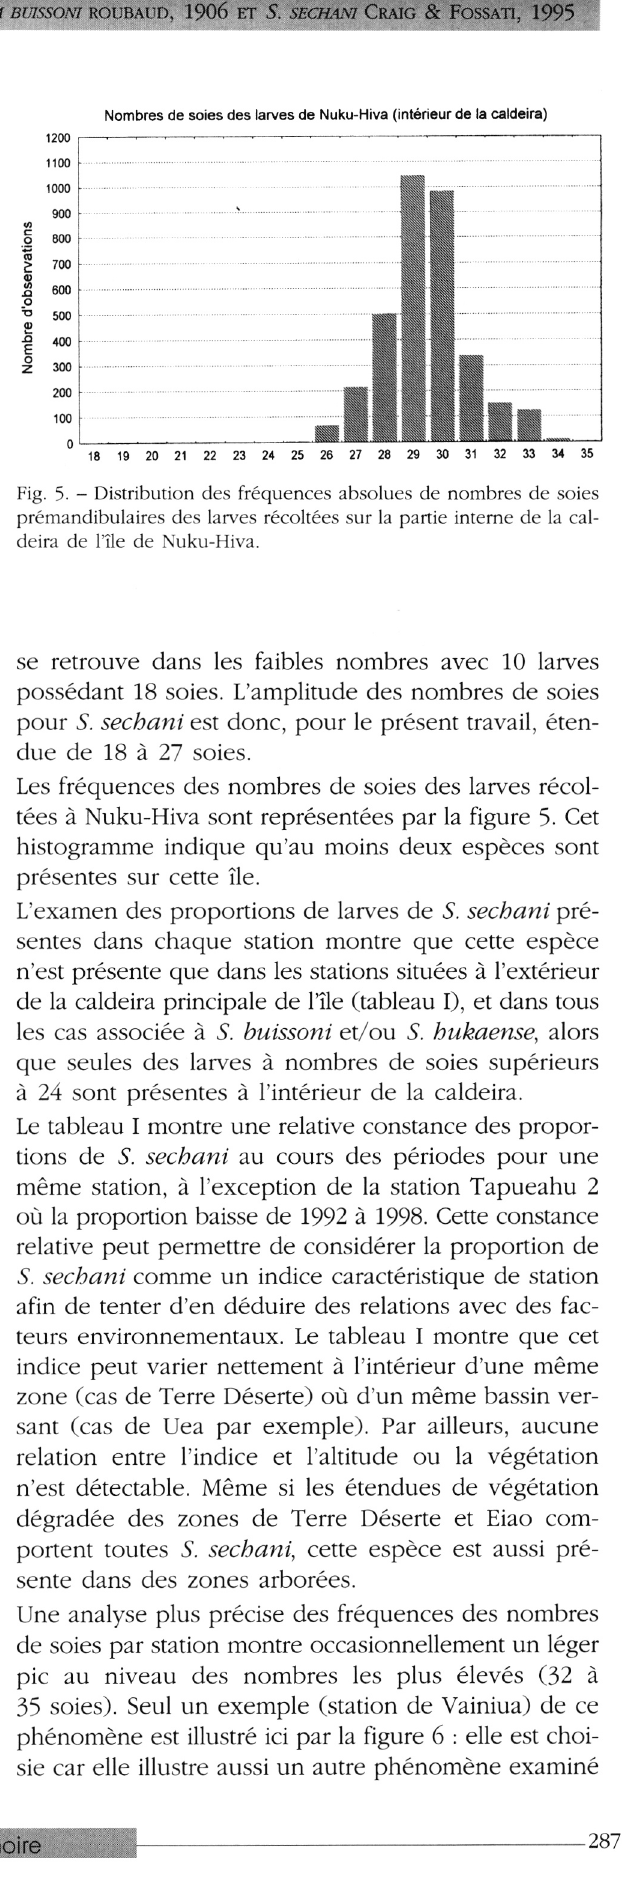
Fig. 4. - Distribution des fréquences absolues de nombres de soies prémandibulaires des larves récoltées sur l’île de Eiao.